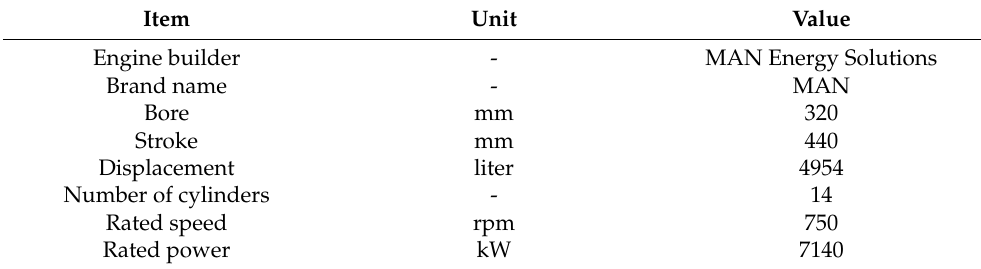
Table 2. Main characteristics of diesel engine